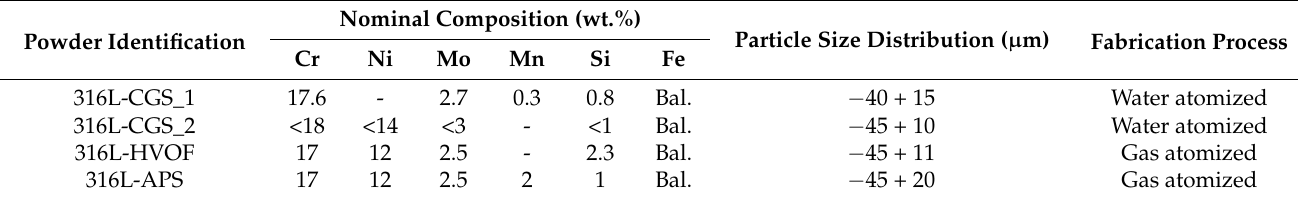
Table 1. Feedstock